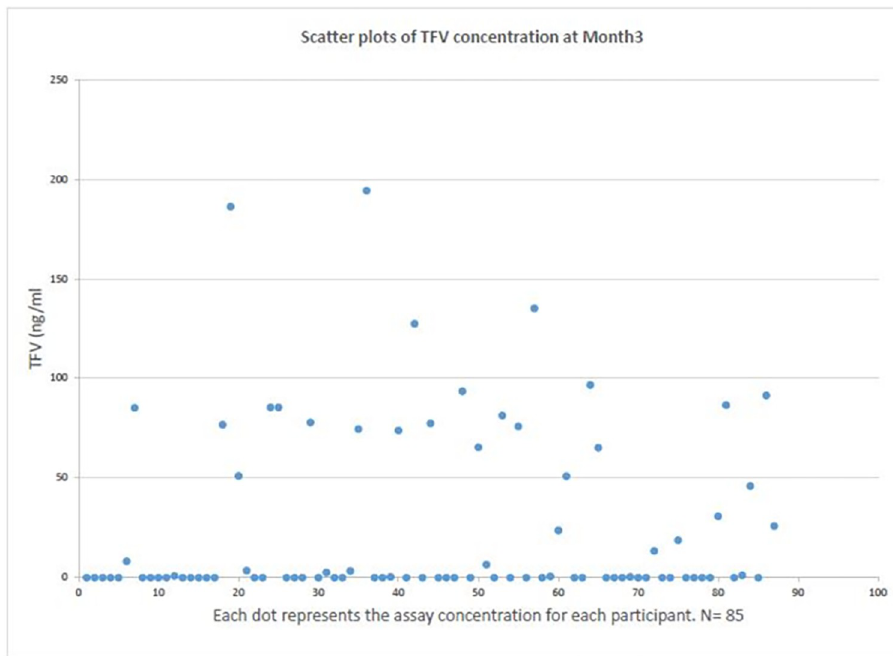
Fig 1. Scatter plots of absolute TFV concentration at Month